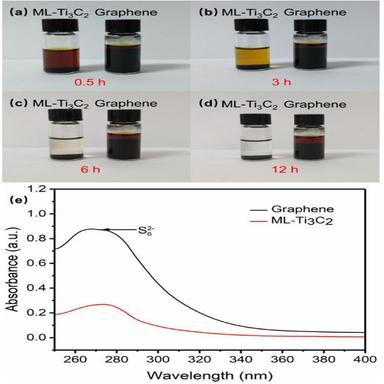
Digital photographs of polysulfide adsorption tests of graphene and ML-Ti3C2 at different times: (a) 0.5 h; (b) 3 h; (c) 6 h; (d) 12 h. (e) UV–Vis spectra of the lithium polysulfide were taken after being stand for 12 h.